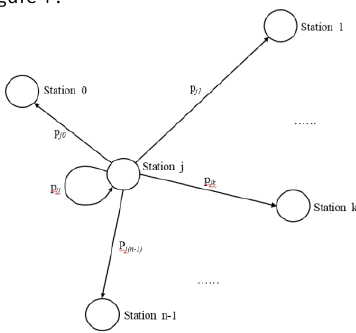
Figure 1. Transition states of station j